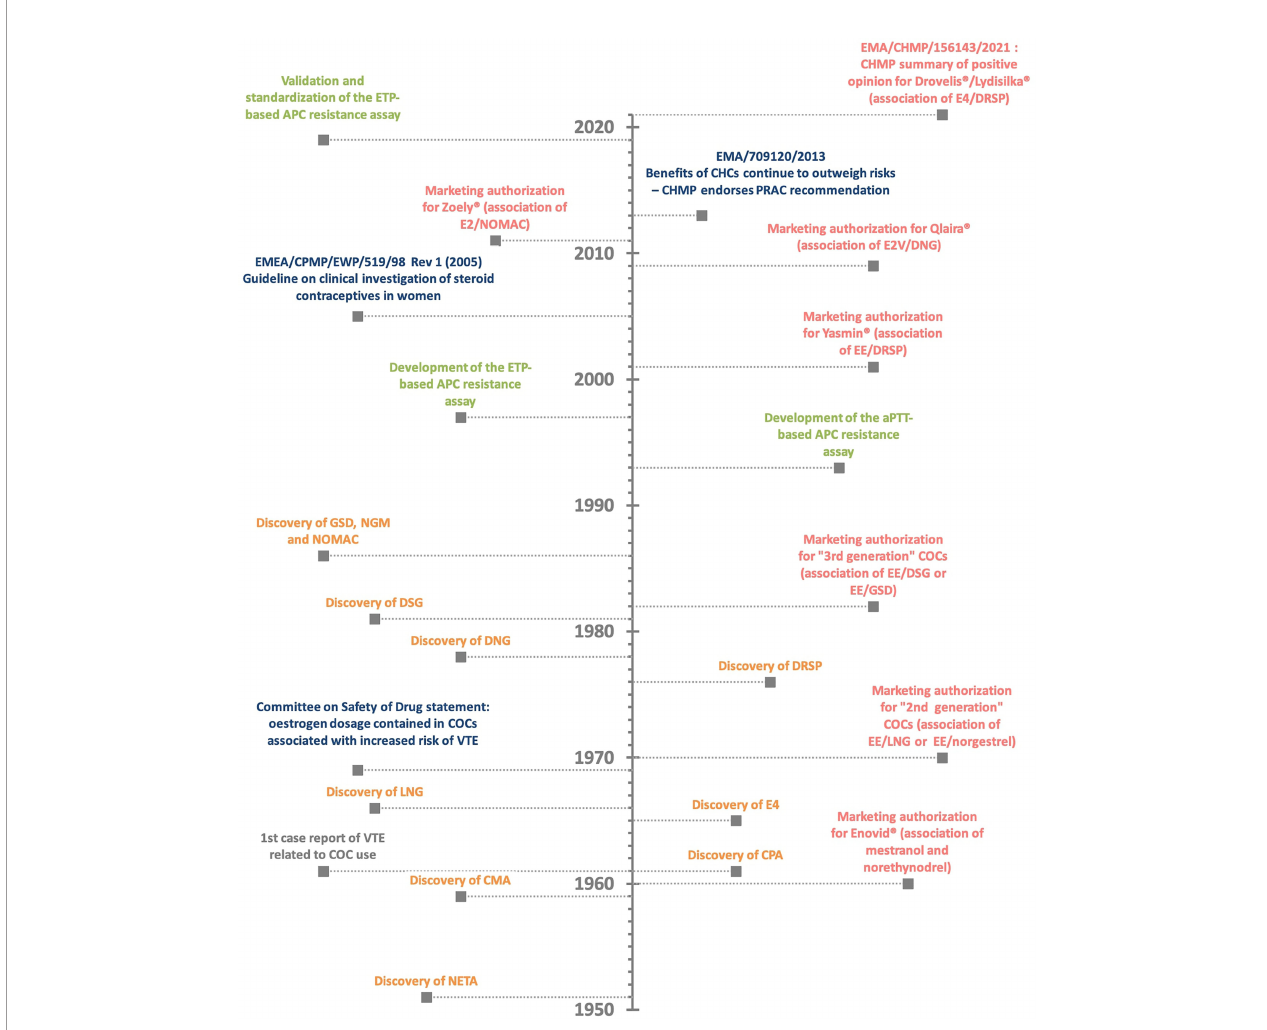
FIGURE 1 | The history of combined oral contraceptive (COC) and the related risk of venous thromboembolism (VTE). Discovery of estrogen and progestin compound (in orange) - marketing authorization for combined oral contraceptives (in red) – authorities ’ statement (in blue) – assay development (in green). APC, activated protein C resistance; aPTT, activated partial thromboplastin time; CHMP, Committee for Medicinal Products for Human Use; CHC, combined hormonal contraceptives; CMA, chlormadinone acetate; COC, combined oral contraceptives; CPA, cyproterone acetate; DNG, dienogest; DRSP, drospirenone; DSG, desogestrel; EE, ethinylestradiol; EMA, European Medicines Agency; ETP, endogenous thrombin potential; E2, 17 b -estradiol; E2V, estradiol valerate; E4, estetrol; GSD, gestodene; LNG, levonorgestrel; NETA, norethisterone acetate; NGM, norgestimate; NOMAC, nomegestrol acetate; PRAC, Pharmacovigilance Risk Assessment Committee; VTE, venous thromboembolism